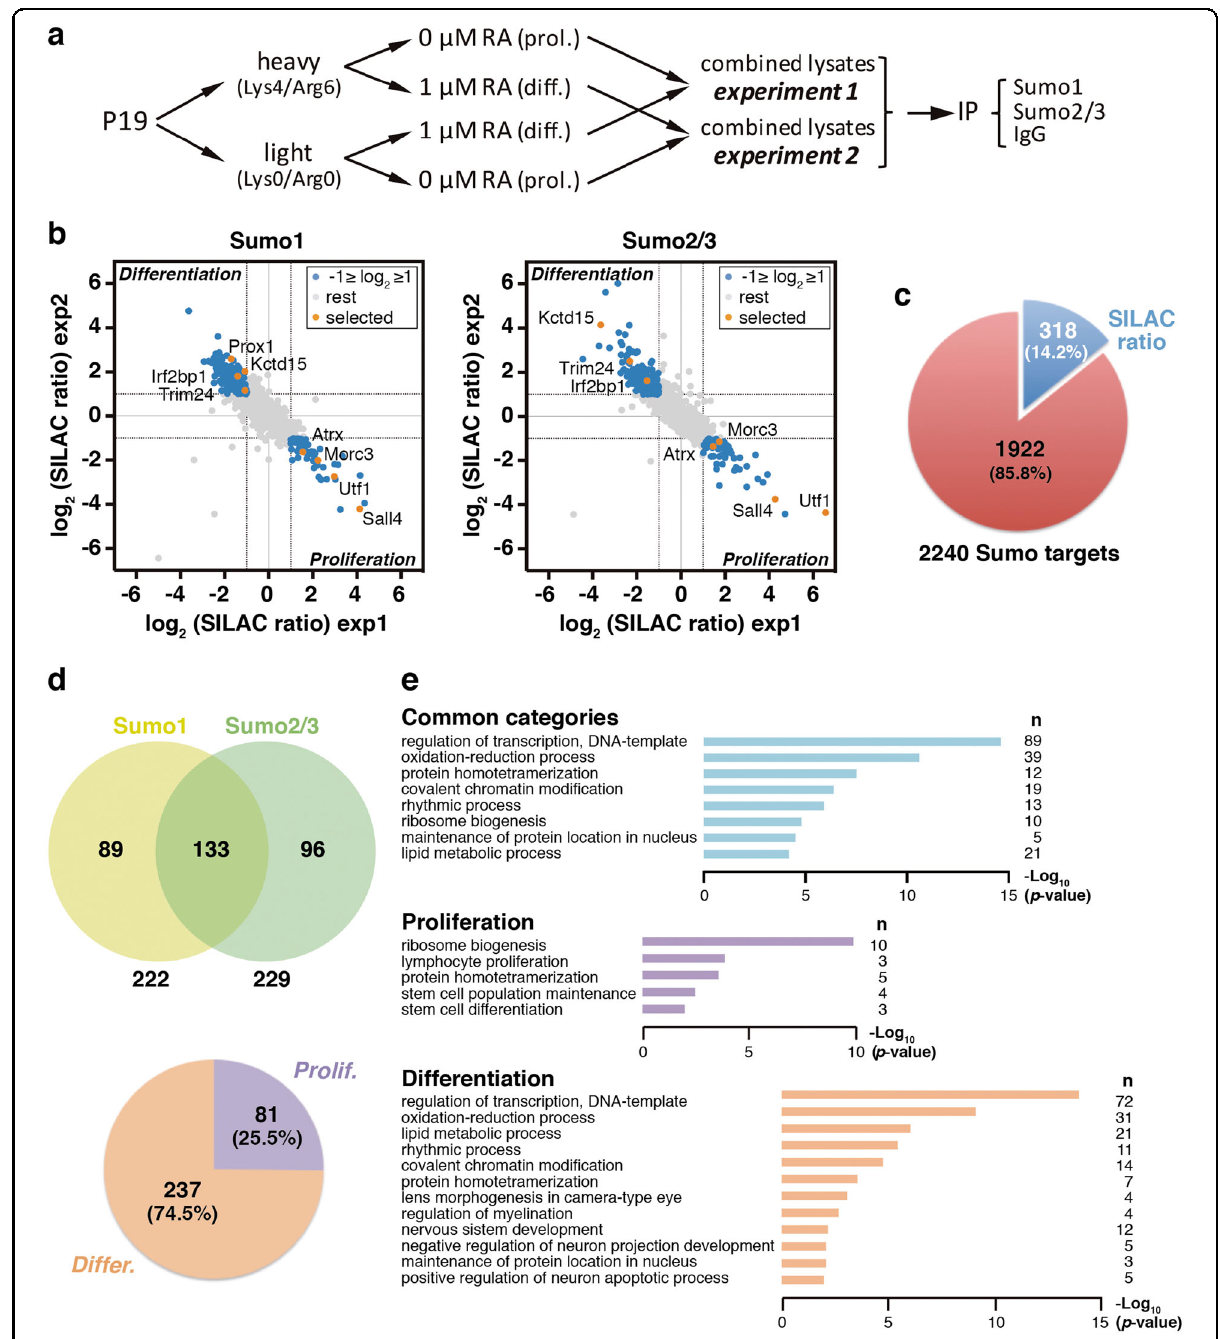
Fig. 1 Induction of neuronal differentiation provokes changes in the Sumo proteome. a Schematic representation of the SILAC approach preceding MS analysis. Cells were labeled with heavy or light amino acids under proliferation (prol.) or retinoic acid (RA)-mediated differentiation (diff.), and lysates were combined for immunoprecipitation (IP). b Scatter plots of Sumo1 and Sumo2/3 putative targets showing a SILAC ratio in both experiments (experiment 1, exp1; experiment 2, exp2). Those with log 2 (SILAC ratio) ≥ 1 in one experiment and a log 2 (SILAC ratio) ≤ − 1 in the other experiment are in blue dots. Selected proteins for subsequent validation are in orange. The upper-left part of each plot includes proteins more sumoylated under differentiation conditions, while the lower-right part includes proteins more sumoylated under proliferation conditions. c Sector diagram showing the number of proteins indicated in blue in ( b ) in relation to the total number of Sumo targets identi fi ed. d Upper part, Venn diagram showing the number of proteins identi fi ed as Sumo1 or Sumo2/3 targets out of 318 proteins. Lower part, sector diagram showing the proportion of these proteins preferentially sumoylated under proliferation or differentiation conditions. e Gene ontology (GO) analysis of genes coding for the 318 proteins (common categories, p value <10 − 4 ), and GO analysis of genes coding for proliferation- or differentiation-associated targets ( p value <10 − 2 ). n number of genes in each